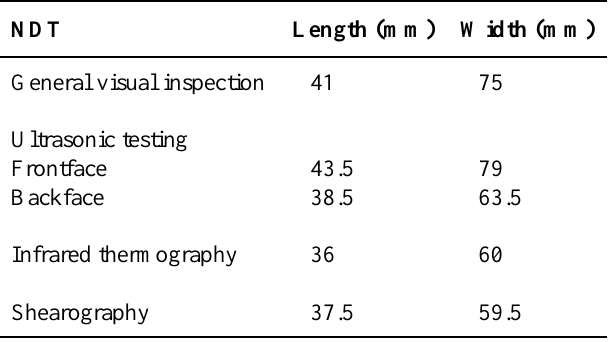
Table 1. Comparison of various NDT